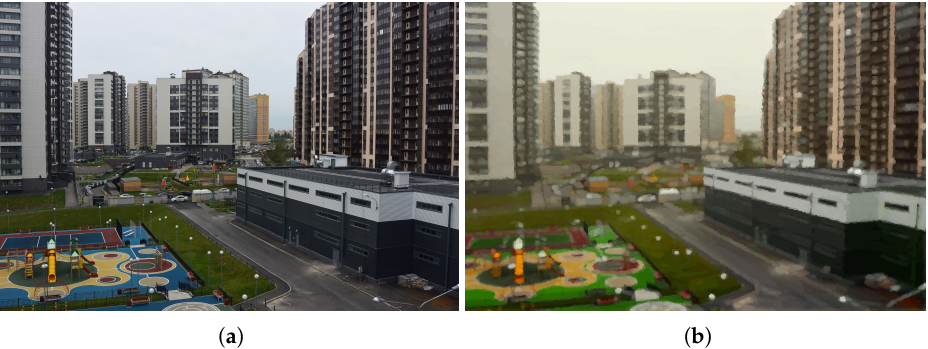
Figure 10. The source image ( a ) was processed using all four stages: aerial perspective enhancement, gamut compression for achieving an effect of yellowed old paints, contrast-saturation correction and, finally, brushstroke rendering with improved coherence. The rendering result ( b ) represents a simulation of generated plotter file ready for robotic artistic